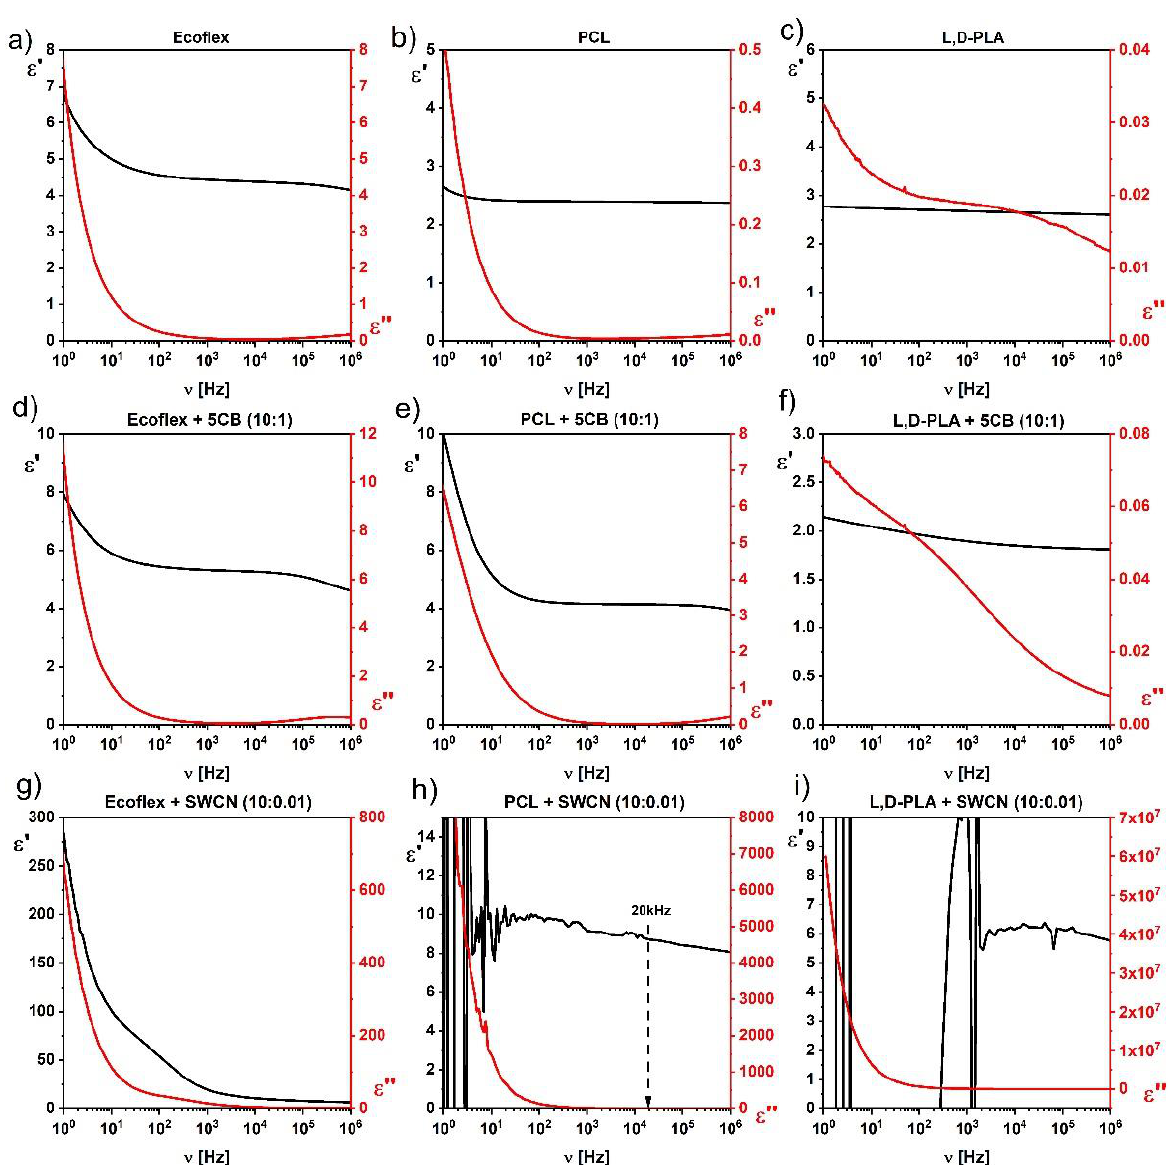
Figure 6 . Real and imaginary part of dielectric permittivity for pure Ecoflex ® ( a ), PCL ( b ), L,D-PLA ( c ), with additives 5CB ( d – f ) and SWCN ( g – i ).